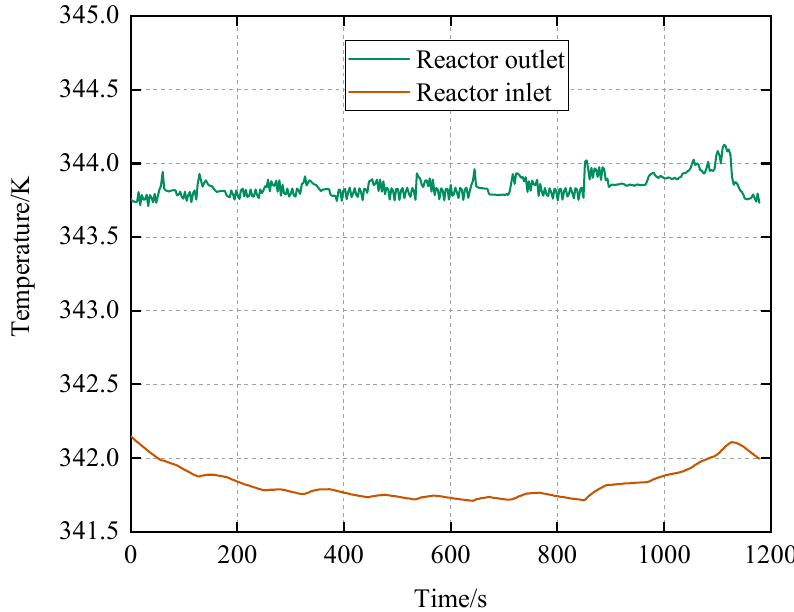
Figure 13. Diagram of temperature variation inside a fuel cell.